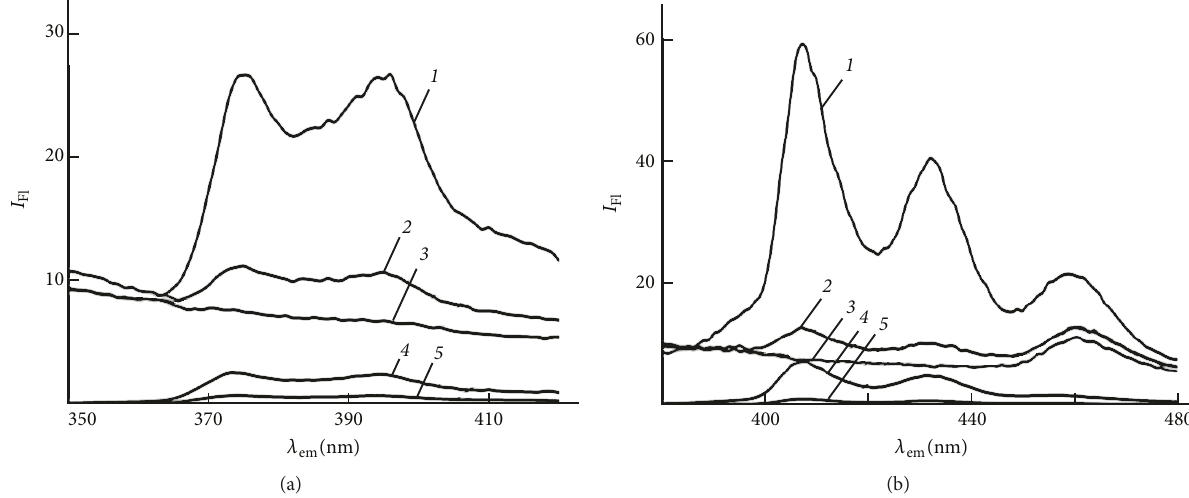
Figure 1: Fluorescence spectra of (a) pyrene and (b) benzo(a)pyrene: 1 : sorbed onto a CDA matrix from a water-ethanol solution with a concentration of 10 −4 g/L; 2 : sorbed from the solution with a concentration of 10 −5 g/L; 4 : in a water-ethanol solution with a concentration of 10 −4 g/L; 5 : in a water-ethanol solution with a concentration of 10 −5 g/L; and 3 : fluorescence spectra of the CDA matrix. The spectra were obtained using 𝜆 ex = 320 nm for pyrene, 𝜆 ex = 296nm for